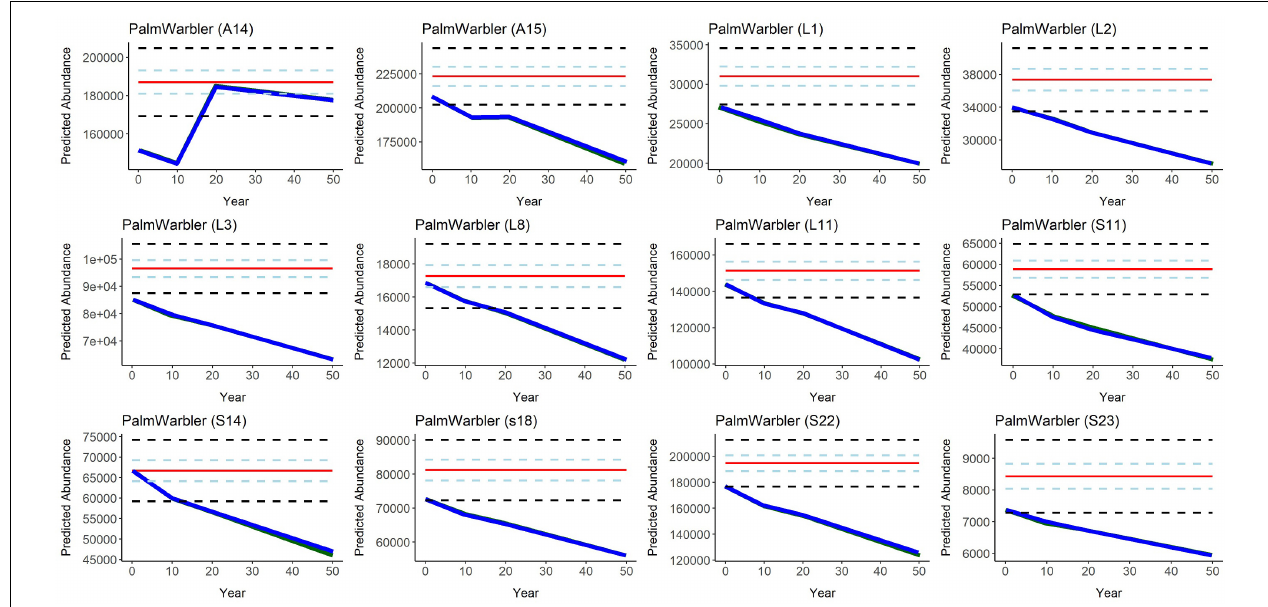
FIGURE 6 | Predicted Palm Warbler abundance over time (year 0-50, where year 0 = 2016) in all 12 Forest Management Units in the Al-Pac Forest Management Area, under two scenarios: (1) the Preferred Forest Management Scenario (PFM) that included harvest deferral within caribou habitats (green line); and (2) the Ecosystem-Based Management/Natural Disturbance Model Scenario (EBM) without harvest deferral (blue), relative to the predicted Natural Range of Variation (NRV) in Palm Warbler abundance in the absence of human footprint. Red line = mean predicted Palm Warbler abundance per Forest Management Unit in the NRV Scenario. Light blue dashed lines = 50% confidence intervals for mean predicted Palm Warbler abundance in the NRV Scenario. Black dashed lines = 95% confidence interval estimates in the NRV Scenario. SDMs predicted that Palm Warbler densities were in black spruce stands 40–80 years old, which are preferred as habitat by woodland caribou but are not harvested by Al-Pac; therefore habitat availability for and projected numbers of Palm Warblers were virtually the same under both Patchworks scenarios. Average black-spruce forest age increased in most FMUs over 50 years in the Patchworks simulations, reducing habitat for Palm Warblers, while simulated fires reduced forest age and increased habitat for these species in the NRV